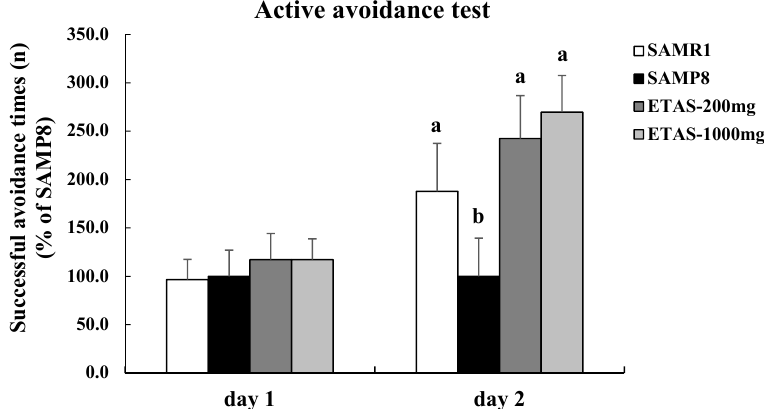
Figure 1. Mean number of successful active avoidance among 20 trials of shuttle avoidance test in 3-month-old SAMP8 mice fed with a different diet for 12 weeks. The y axis denotes the percentage of each group compared to SAMP8 control group. Values were mean ± S.E.M. (n = 8/group). Data with different superscripts are significantly different among groups.